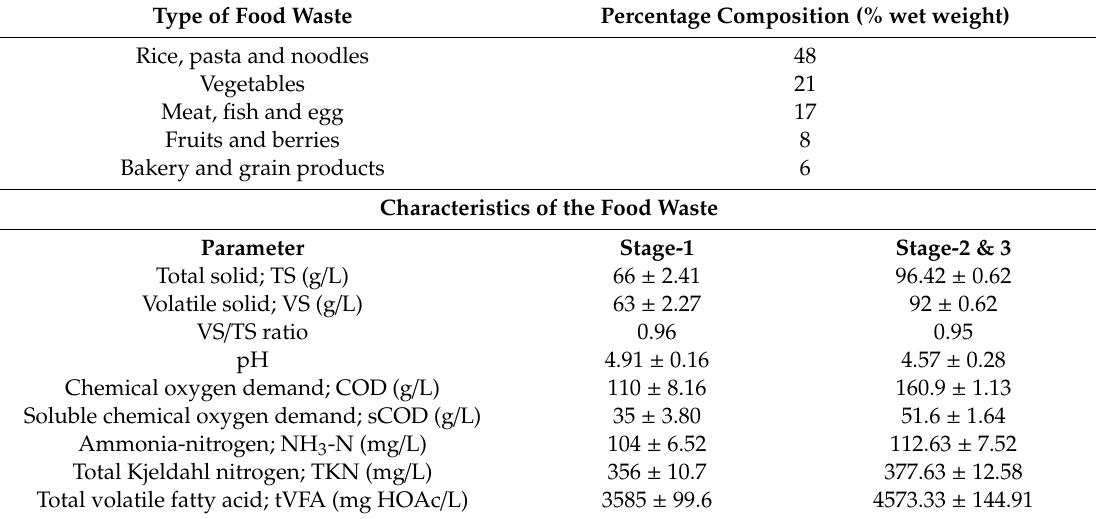
Table 1. Composition and characteristics of the food waste used in this